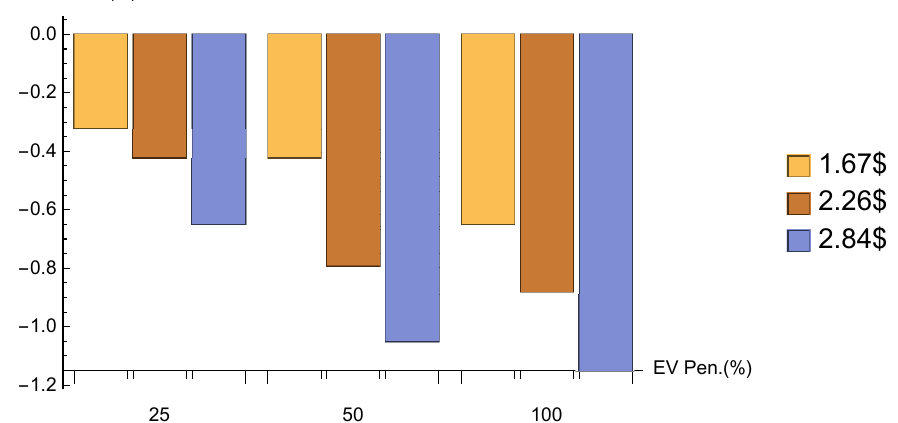
Figure 12. CO 2 variations for different EV penetration levels and diesel prices between cases B and